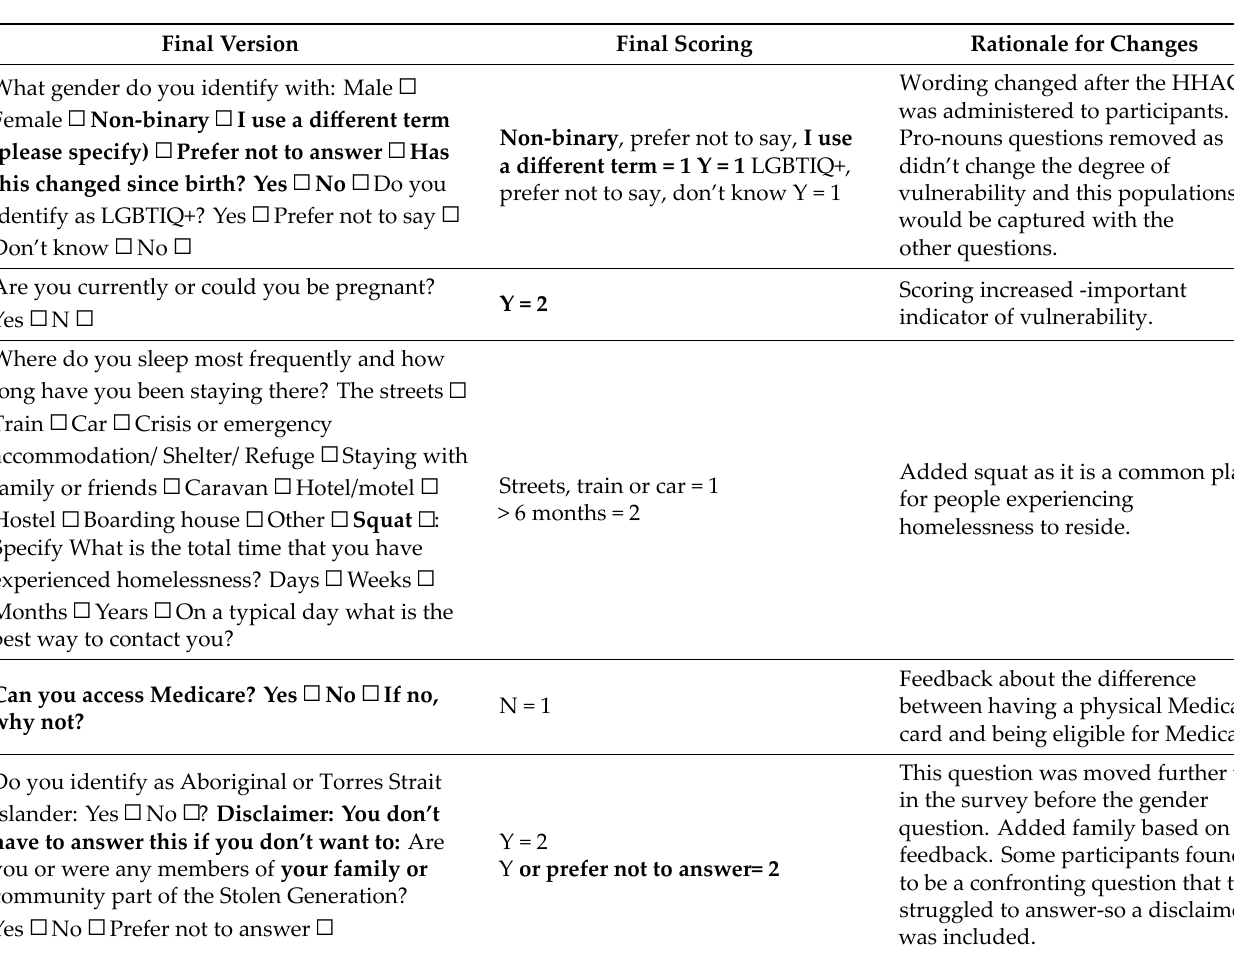
Table 5. Change made to HHACT Survey (highlighted in bold) [15] Re‑use permitted under CC BY‑NC., 2022, Jane Currie, et